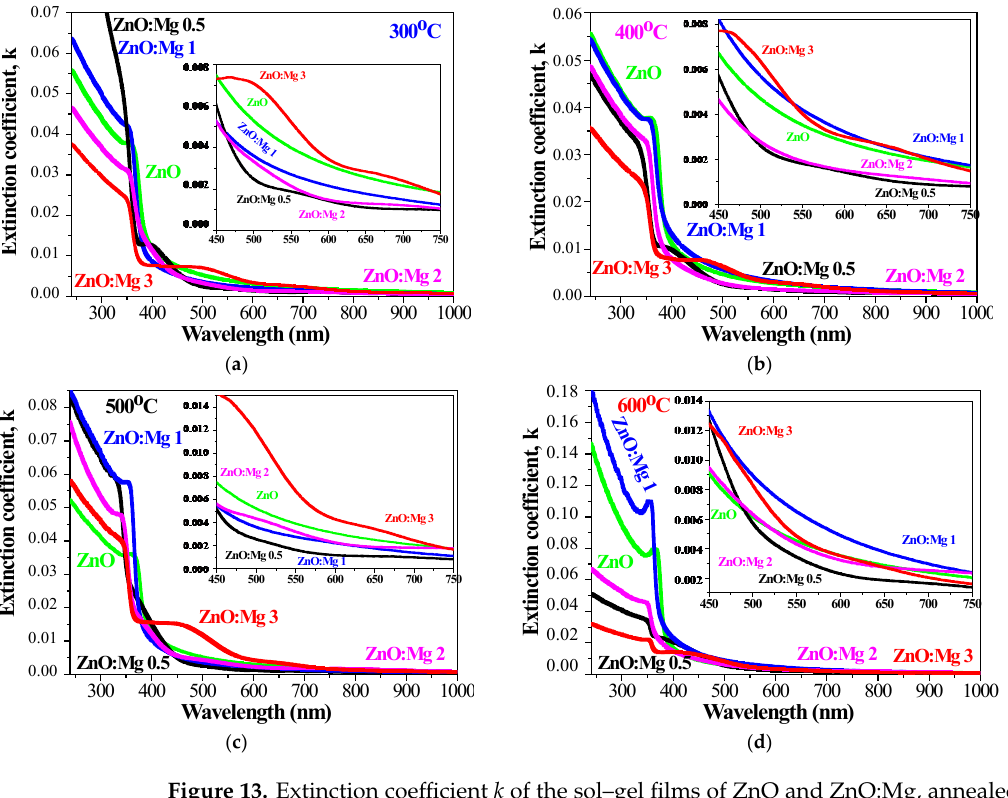
Figure 13. Extinction coefficient k of the sol–gel films of ZnO and ZnO:Mg, annealed at ( a ) 300 °C films, ( b ) 400 °C, ( c ) 500 °C and ( d ) 600 °C. The inset figures show the extinction values in the spectral range 450–750 nm.